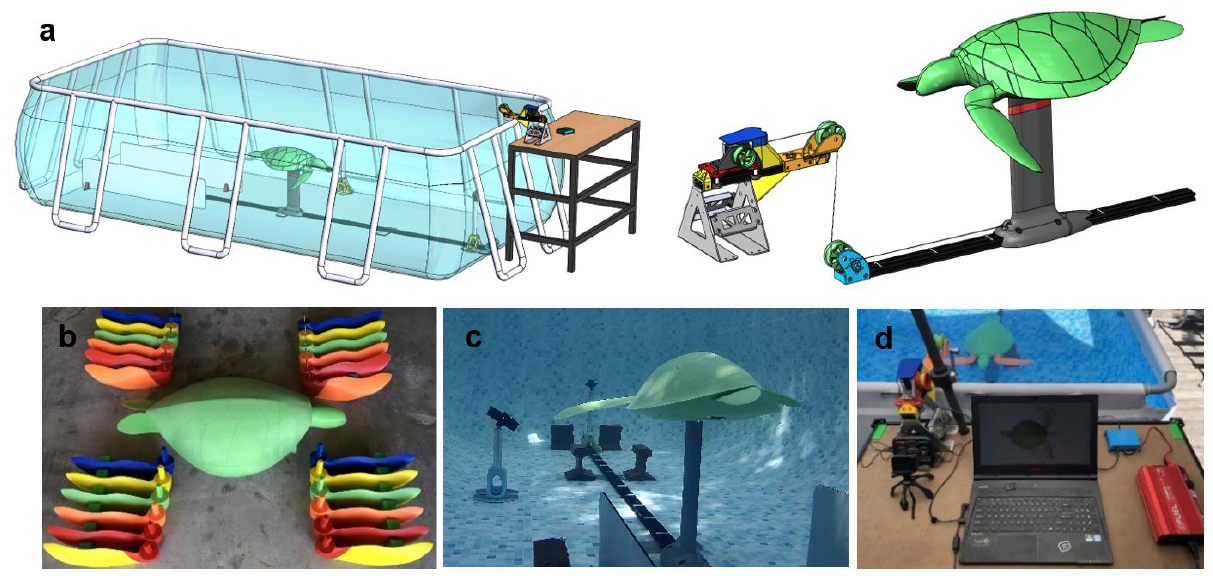
Figure 2. Test rig assembly. ( a ) Complete test rig assembly CAD model, with a closeup of pully assembly shown at the top right. ( b ) The 3D-printed turtle with all wings. Yellow/red and orange/red = 35° twist, red = 28°, orange = 22°, green = 18°, yellow = 15° and blue = 10°. Passive wings are shown above turtle with rigid wings below. All wings are manufactured to the same volume and mass of 226.5 cubic centimetres and 230 g. ( c ) Image showing a typical test. ( d ) Workstation setup.